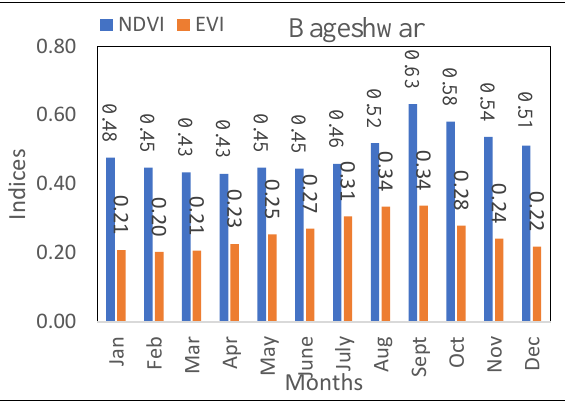
Figure 4. Bageshwar District Vegetation Cover (NDVI and EVI